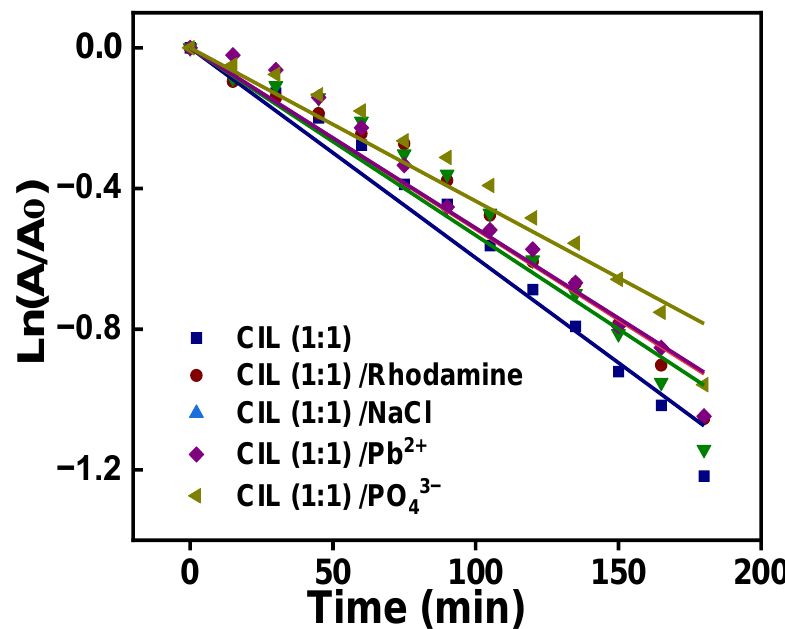
Figure 12. Effect of co-pollutants on photocatalytic activity. Table 6. Pseudo-first-order rate constants showing the effect of co-pollutants on the photocatalytic activity. Co-Pollutant